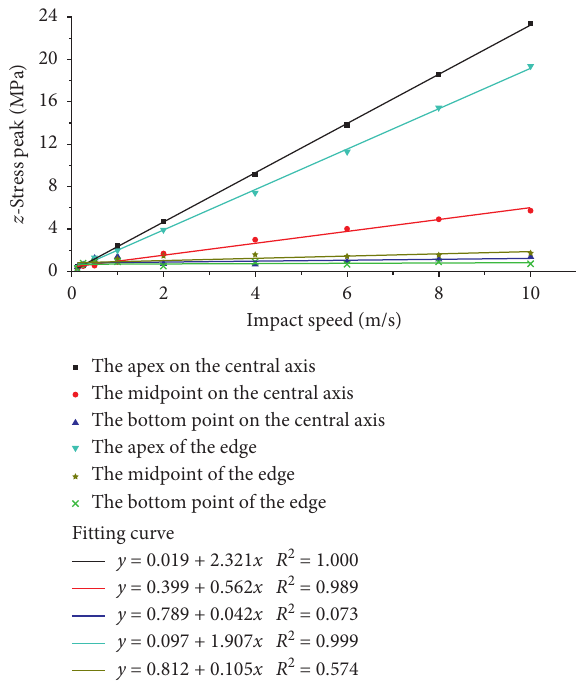
Figure 11: Fitting curve of the impact speed and axial stress peak.